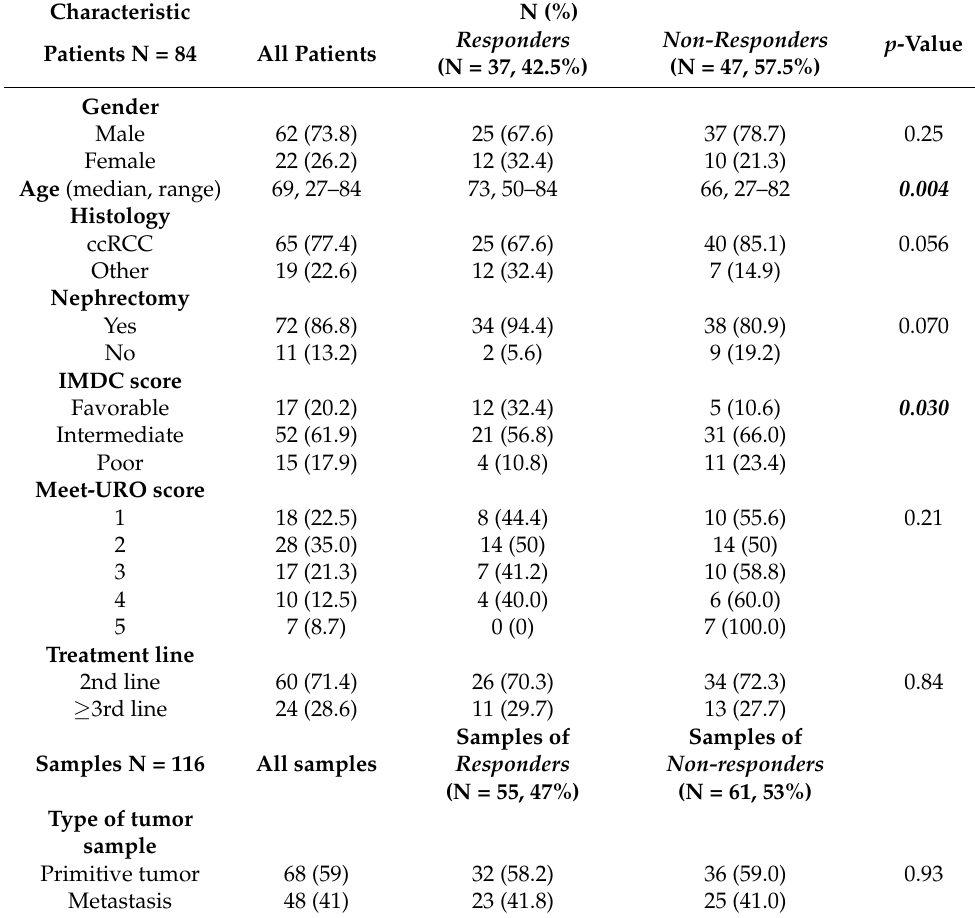
Table 1. Patients’ and tumor samples’